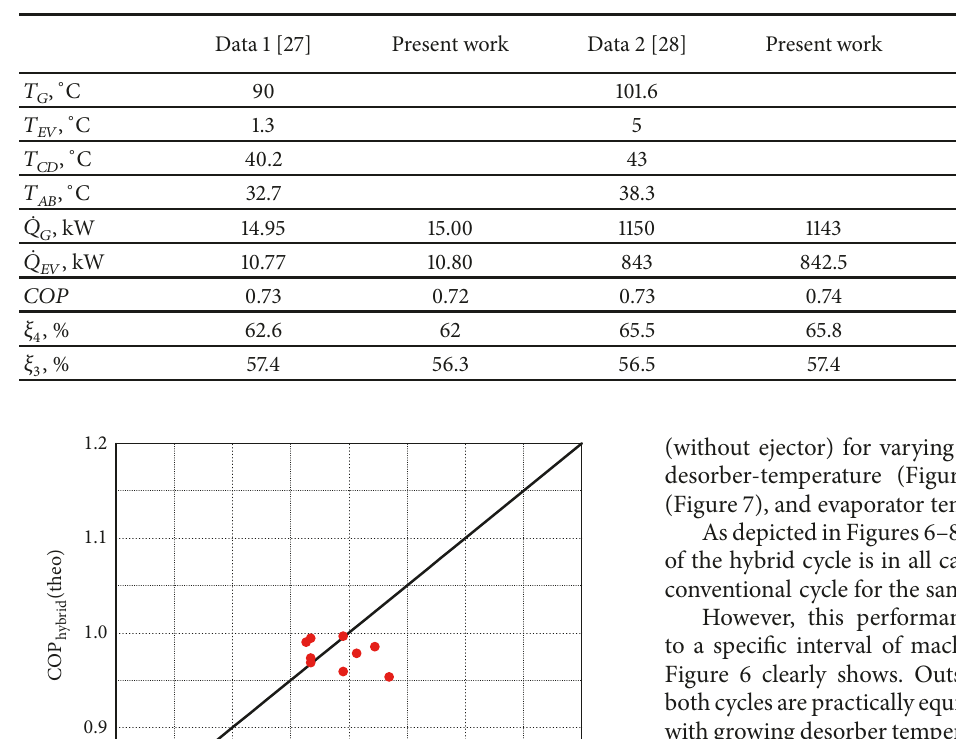
Table 2: Program and machine model validation.